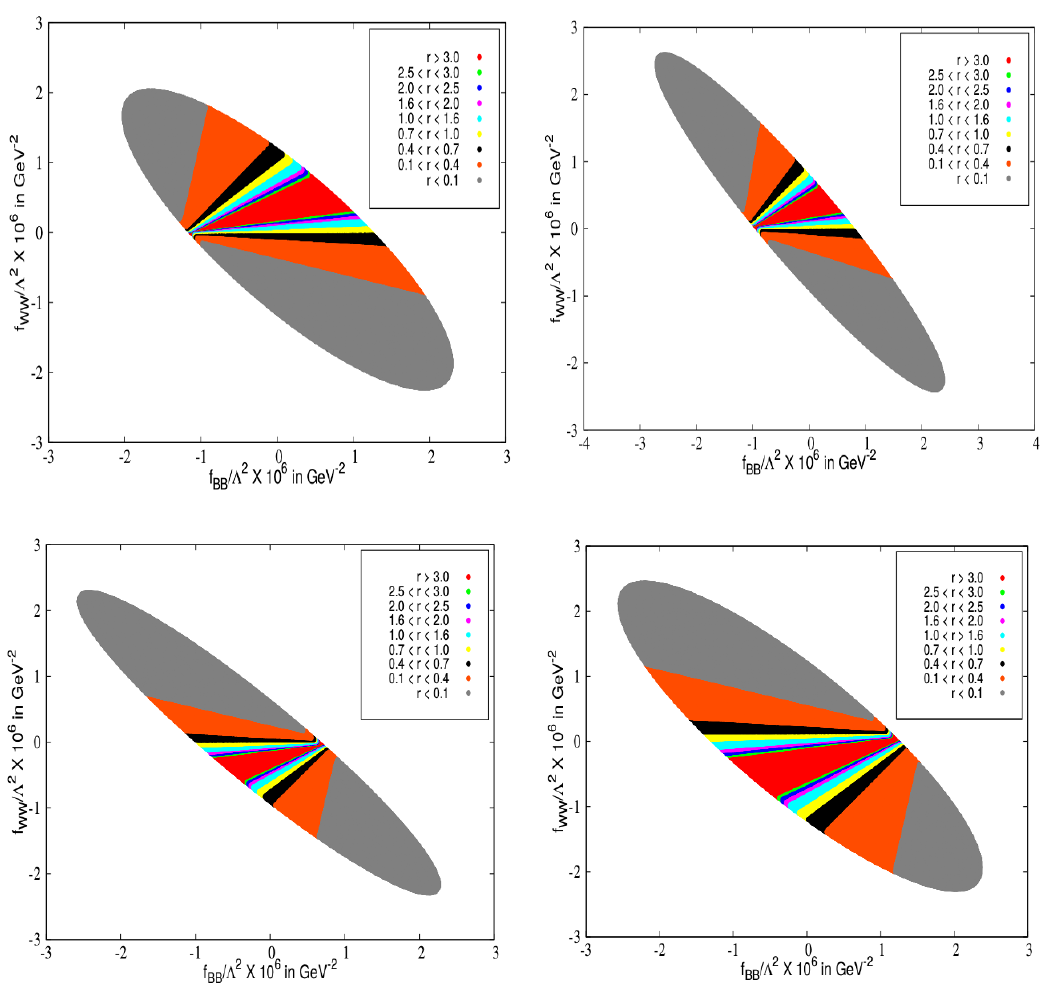
Figure 15 . The ratio r in f BB - f WW plane for Type I(top left), Type II(top right), Lepton- speci(cid:12)c(bottom left) and Flipped 2HDM(bottom right). The ellipses denote the regions allowed at 2 (cid:27)